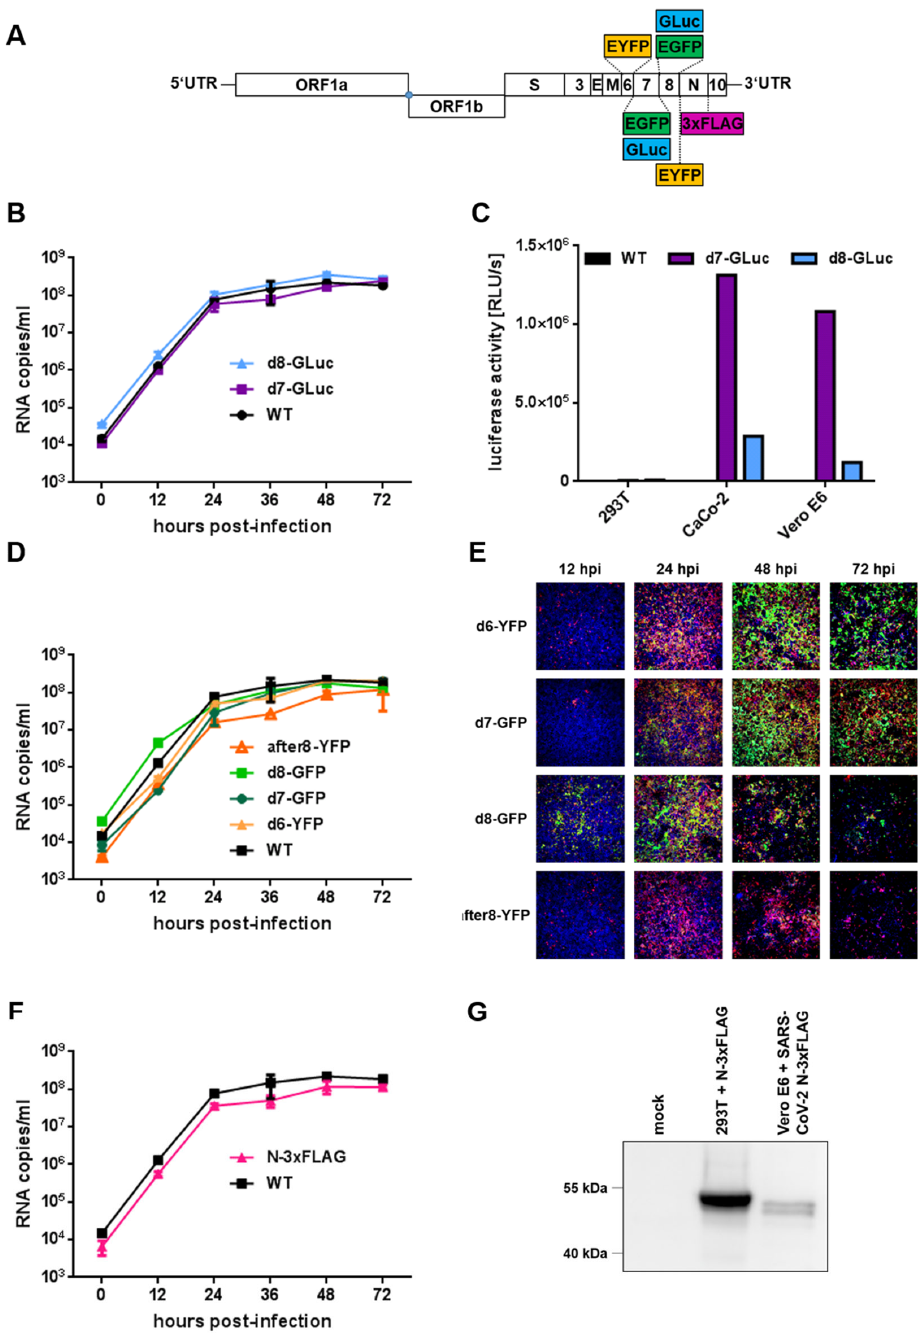
Figure 3. Generation and characterization of recSARS-CoV-2 reporter viruses. ( A ) Schematic depiction of recSARS-CoV-2 reporter and marker viruses. The illustration is not to scale. ( B ) Replication kinetics of luciferase reporter viruses. CaCo-2 cells were infected with recSARS-CoV-2 WT, as well as reporter viruses expressing gaussia luciferase (GLuc) instead of viral ORF7a (d7) and ORF8 (d8), respectively (MOI = 0.005). Cell culture supernatants were collected at the indicated time points post-infection, and viral RNA was quantified by RT-qPCR targeting the viral polymerase RdRp. ( C ) Luciferase assay for the detection of viral replication. HEK293T cells were transfected with pBSCoV2 (WT), pBSCoV2-d7-GLuc, or pBSCoV2-d8-GLuc. After 3 days, the supernatant was passaged on to CaCo-2 or Vero E6 cells. Cell culture supernatants were analyzed for GLuc activity three days post-transfection and post-infection, respectively. Luciferase activity is depicted as relative light units per second (RLU/s). ( D ) Replication kinetics of fluorescence reporter viruses. CaCo-2 cells were infected at an MOI of 0.005 with recSARS-CoV-2 WT and different reporter viruses expressing either GFP or YFP instead of viral ORF6 (d6), ORF7a (d7), and ORF8 (d8), or as an additional gene between ORF8 and N (after8). Cell culture supernatants were collected at the indicated time